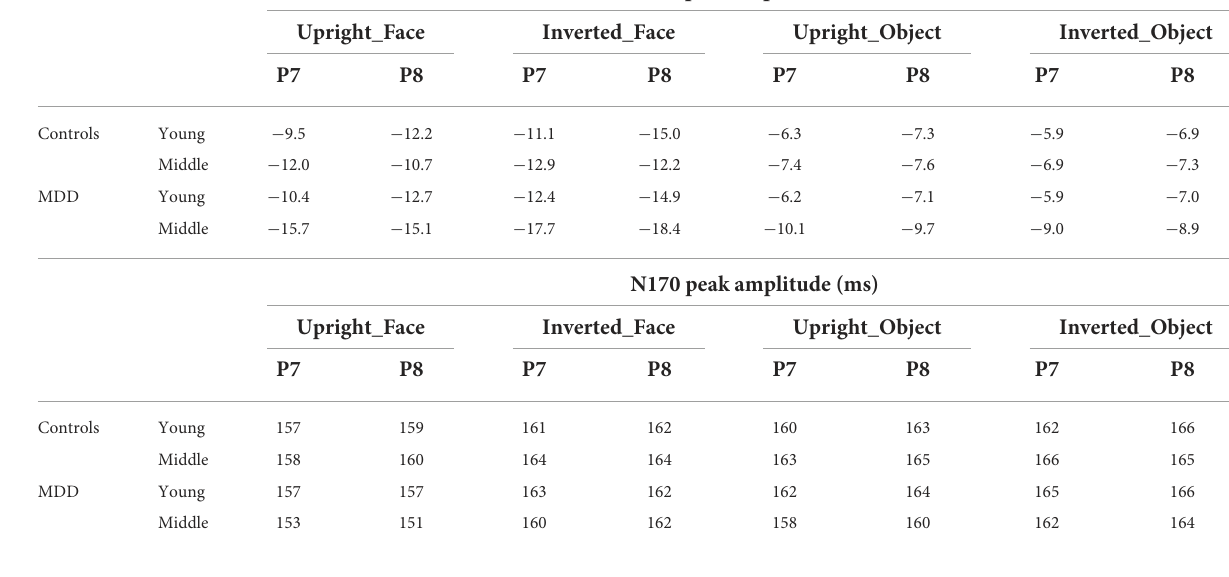
TABLE 2 The peak amplitudes and latency of N170 in control and MDD groups,